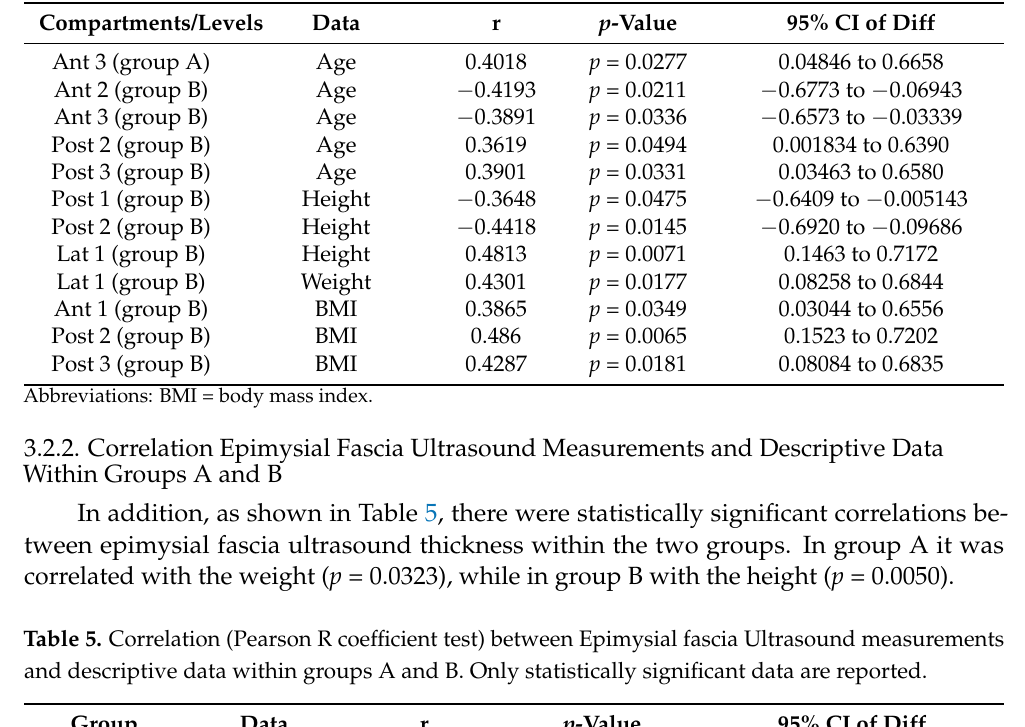
Table 4. Correlation (Pearson R coefficient test) between Deep/crural fascia Ultrasound measure- ments and descriptive data within groups A and B. Only statistically significant data are reported.